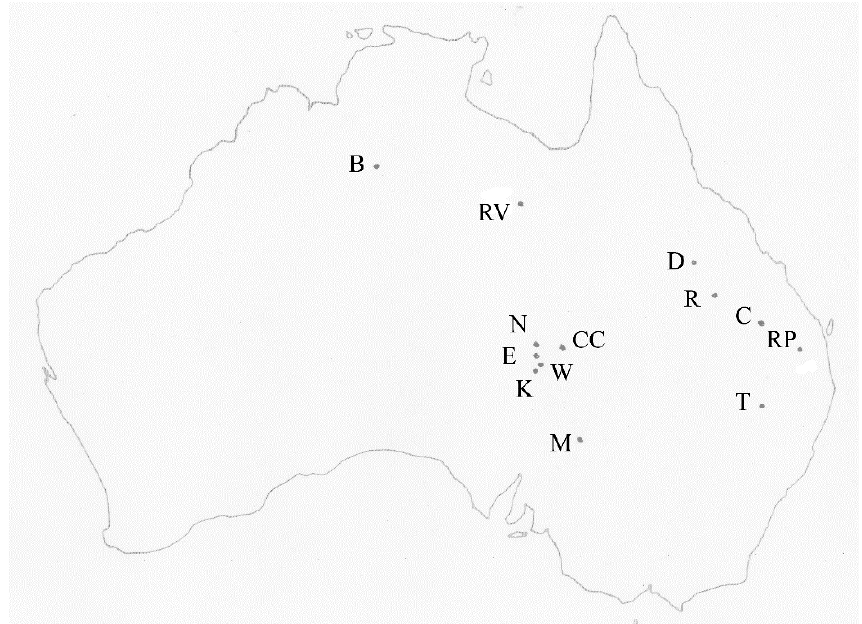
Figure 5. Tertiary and Quaternary fossil deposits in Australia. B. Bullock Creek. C. Chinchilla and King Creek. CC. Cooper Creek. D. Duaringa. E. Etadunna. K. Katapiri. M. Moorna. N. Namba. R. Rundle. RV. Riversleigh. RP. Redbank Plains. T. Toorale. W. Wipijiri.